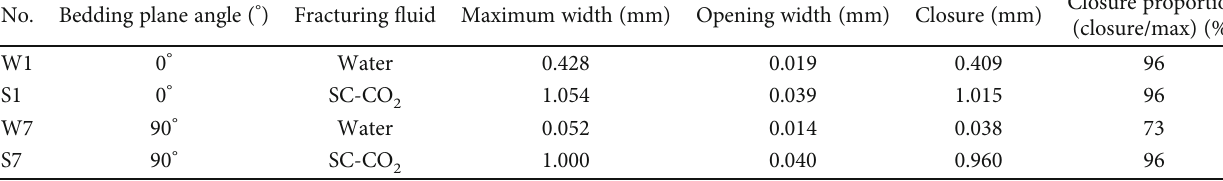
Figure 9: Microscopic images of the local cracks fractured using (a) water and (b) SC-CO Table 5: Variation of the fracture width during the hydraulic fracturing experiments. No. Bedding plane angle ( °